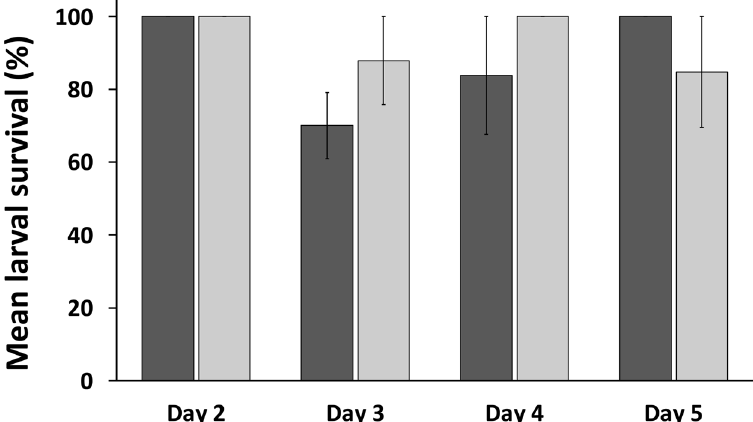
Figure 3. Toxicity experiments measure the proportion of larvae exposed to two different cryoprotectant solutions (cryoprotectant solution 1: 7.5% (v/v) DMSO, 7.5% (v/v) PG, and 1 M trehalose in PBS, dark columns; cryoprotectant solution 2: 5% (v/v) DMSO, 10% (v/v) PG, and 1 M trehalose in PBS, light columns) that resumed swimming at two hours post-rehydration. Solution 2 demonstrated a better than 80% survival on all developmental days, whereas Solution 1 was slightly more damaging to larvae, especially on Day 3. No significant differences were found among any of the cryoprotectant solutions or days ( P > 0.05; Kruskal-Wallis test with Dunn’s multiple-comparisons test). Data are mean ± SEM of n = 3 technical replicates. Each replicate contained 20–40 larvae from a pooled sample of larvae from 10